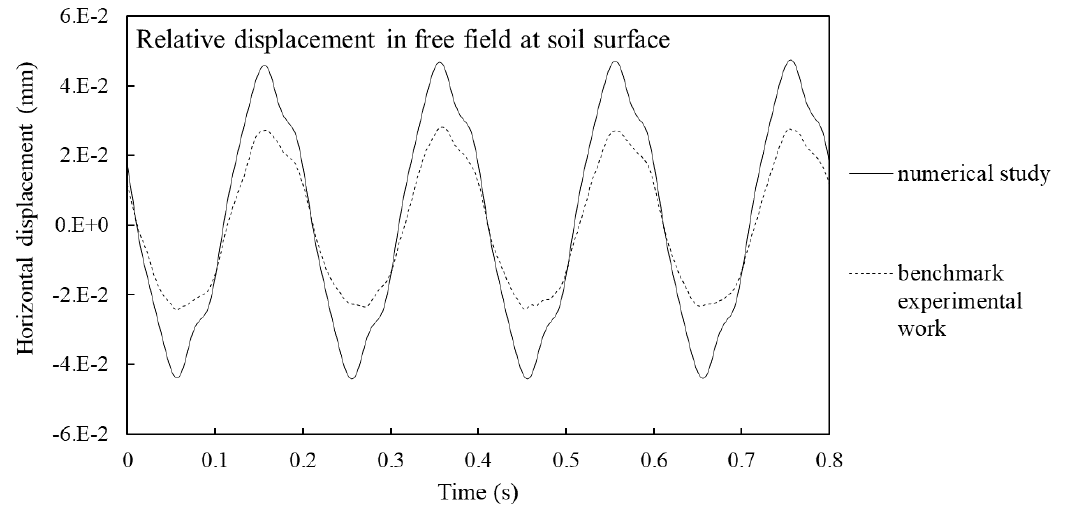
Figure 6: Comparison of relative horizontal displacements between the computations and the experimental measurements (Durante, 2015) obtained in free field in the steady-state